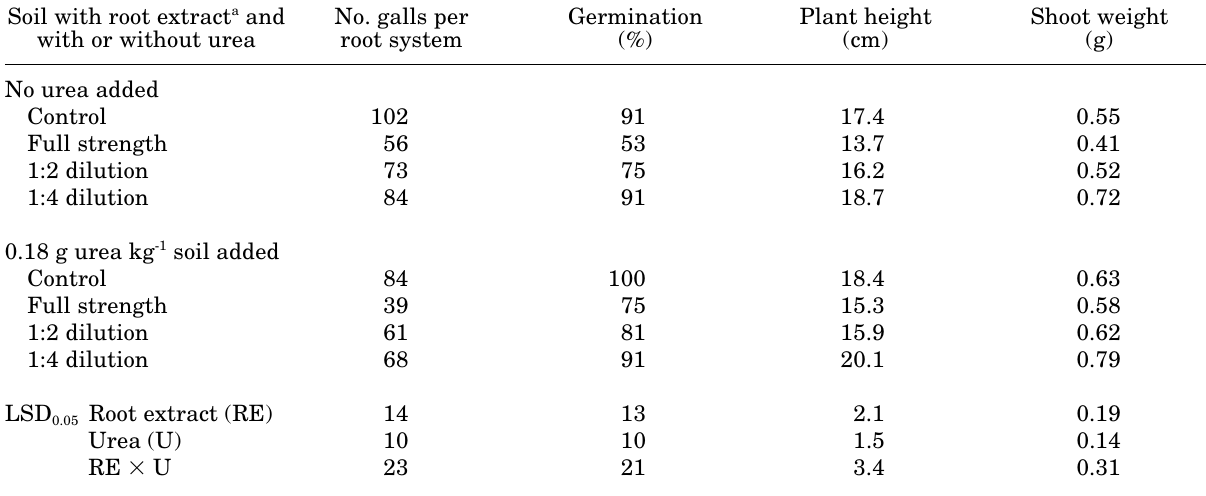
Table 3. Effect of root extracts of Lantana camara at various concentrations with and without urea as N fertiliza- tion, on the development of Meloidogyne javanica root-knot infection and growth of mungbean. Soil with root extract a